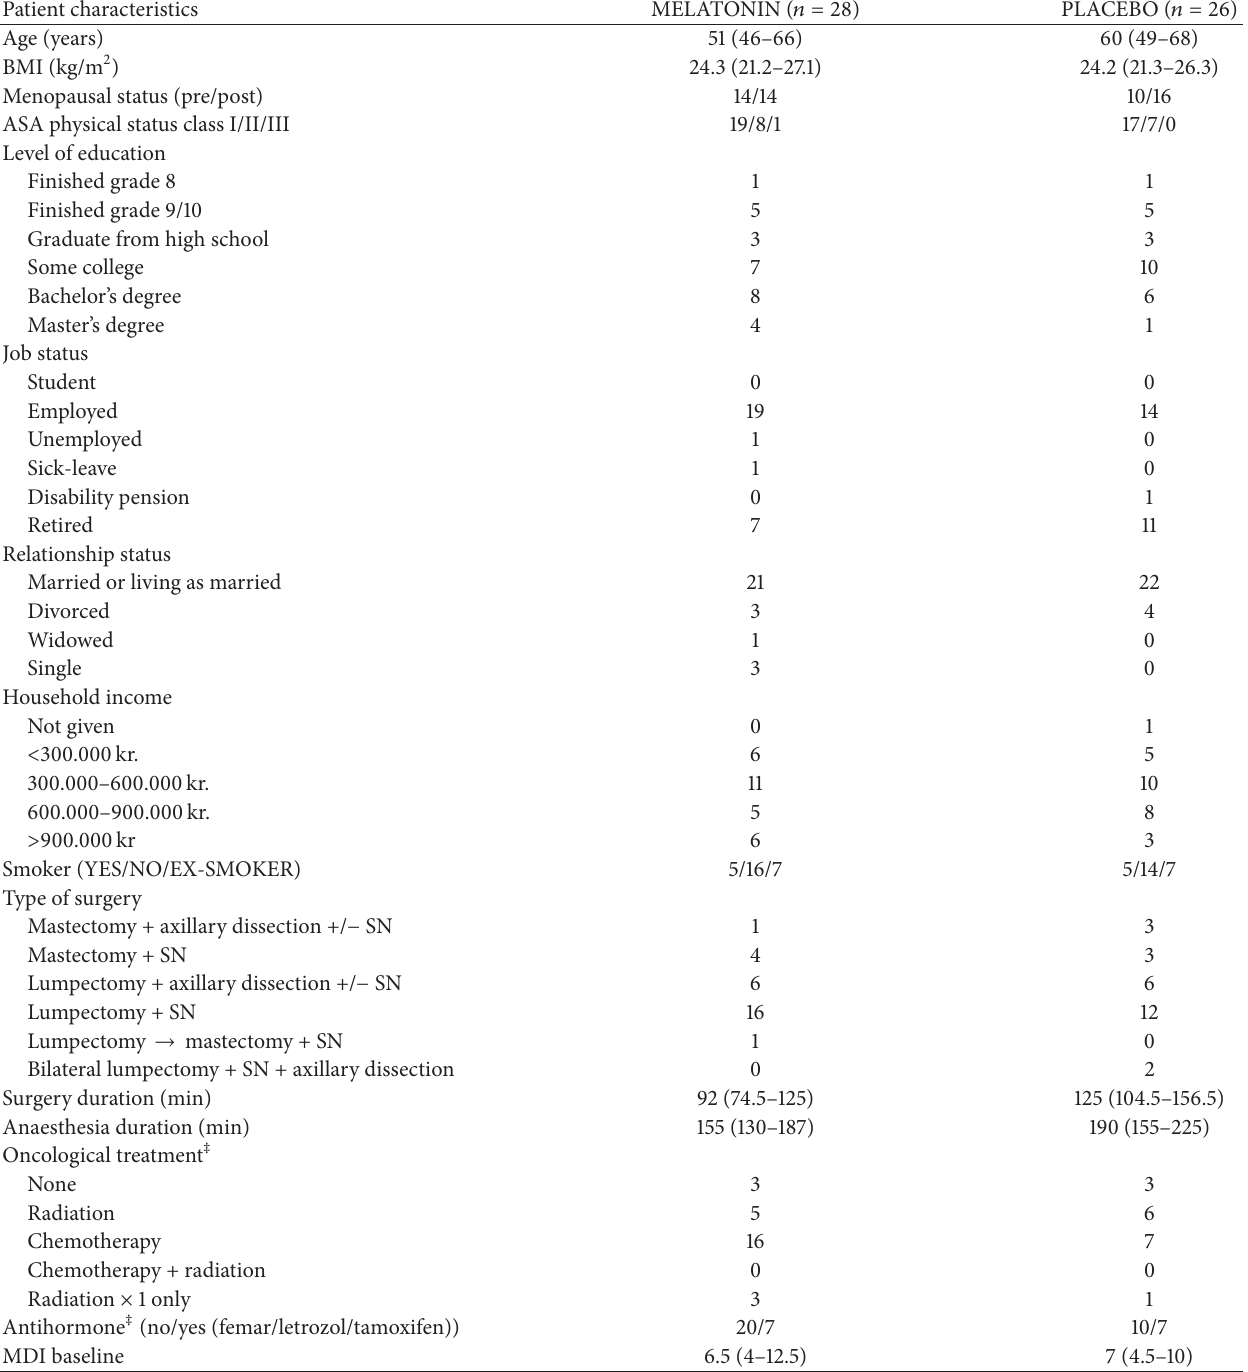
Table 1: Baseline, perioperative, and demographic